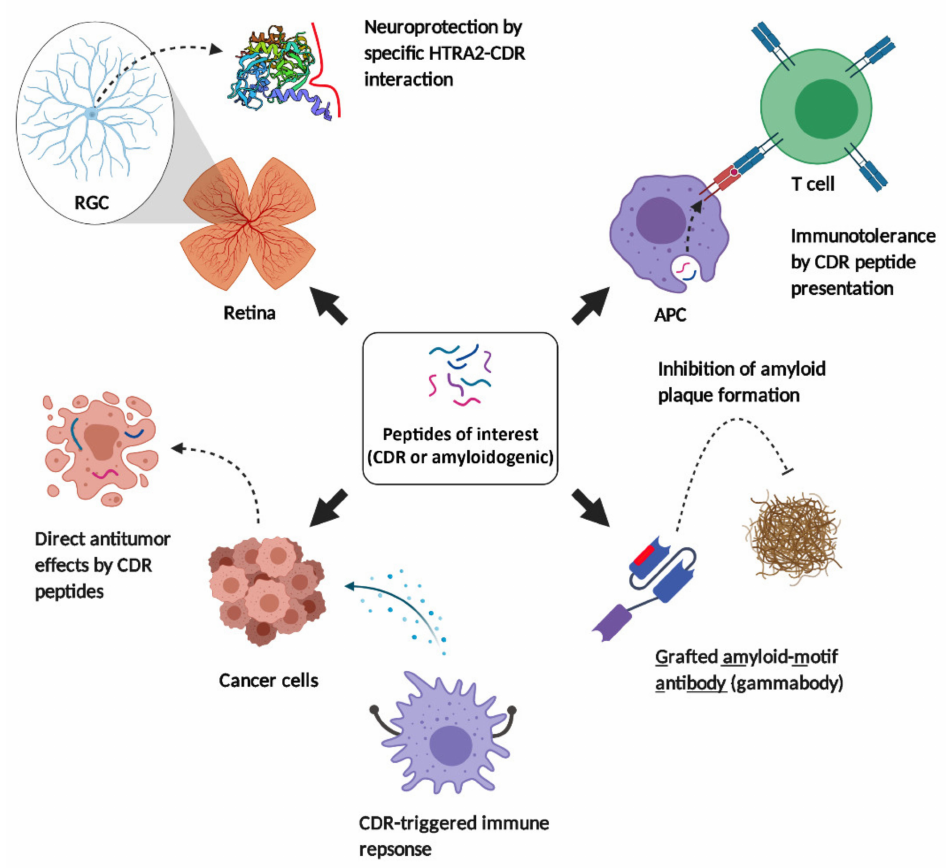
Figure 2. Different modes of action of synthetic CDR peptides and specifically engineered antibodies (gammabodies) for various therapeutic approaches. Synthetic CDR peptides are able to induce immunotolerance in SLE, neuroprotection in glaucoma and antitumor activities in melanoma. Specif- ically engineered antibodies in nanomolecluar size (gammabodies) are able to inhibit the formation of toxic amyloid plaques in Alzheimer’s and Parkinson’s disease. The abbreviation APC defines antigen-presenting cells. The figure was created with